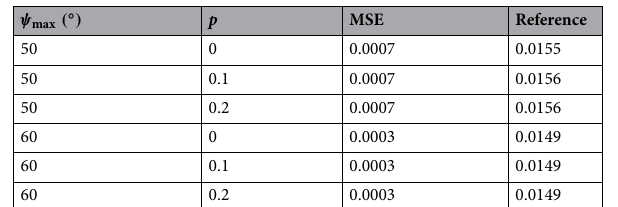
Table 2. MSEs of the pole widths standardization approximation for ψ max of 50 ◦ and 60 ◦ and different amounts of noise (without, 10% , and 20% noise). The simulated pole plots contained 1, 2, or 3 grains equally distributed. Lower values of MSE indicate better approximation. As to be expected, the pole widths standardization approximation is less accurate in case of a higher level of noise. The references were calculated the same way as in Table 1.